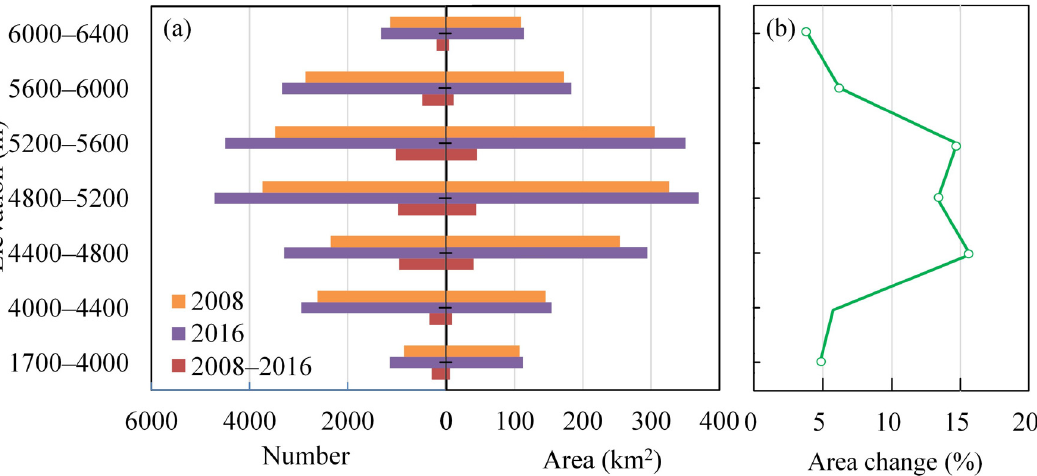
Figure 5. ( a ) Frequency and areal distribution of glacial lakes by elevation class; and ( b ) expansion rate of glacial lake area within the different elevation range from 2008 to 2016.